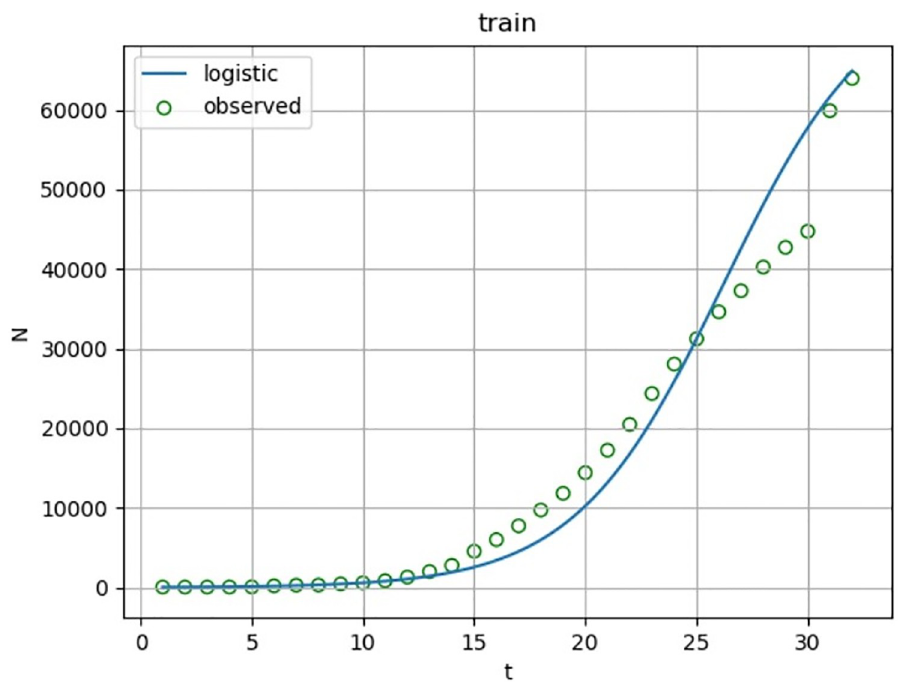
Fig 4. Logistic curve fitting diagram of cumulative confirmed cases of COVID-19. Taking the cumulative confirmed cases of COVID-19 in China from January 13 to February 13, 2020 as a training set, and setting the upper limit M = 76392. And SPSS is used to fit the Logistic curve of the daily cumulative number of confirmed cases in this period.